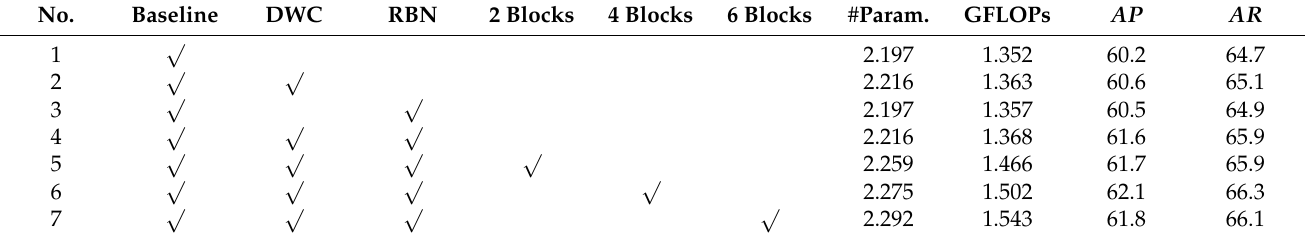
Table 4. Influence of selecting 3 × 3 depthwise convolution (DWC) as the TokenMixture () and representative batch normalization (RBN). We show #param, GFLOPs, AP and AR on AP-10K